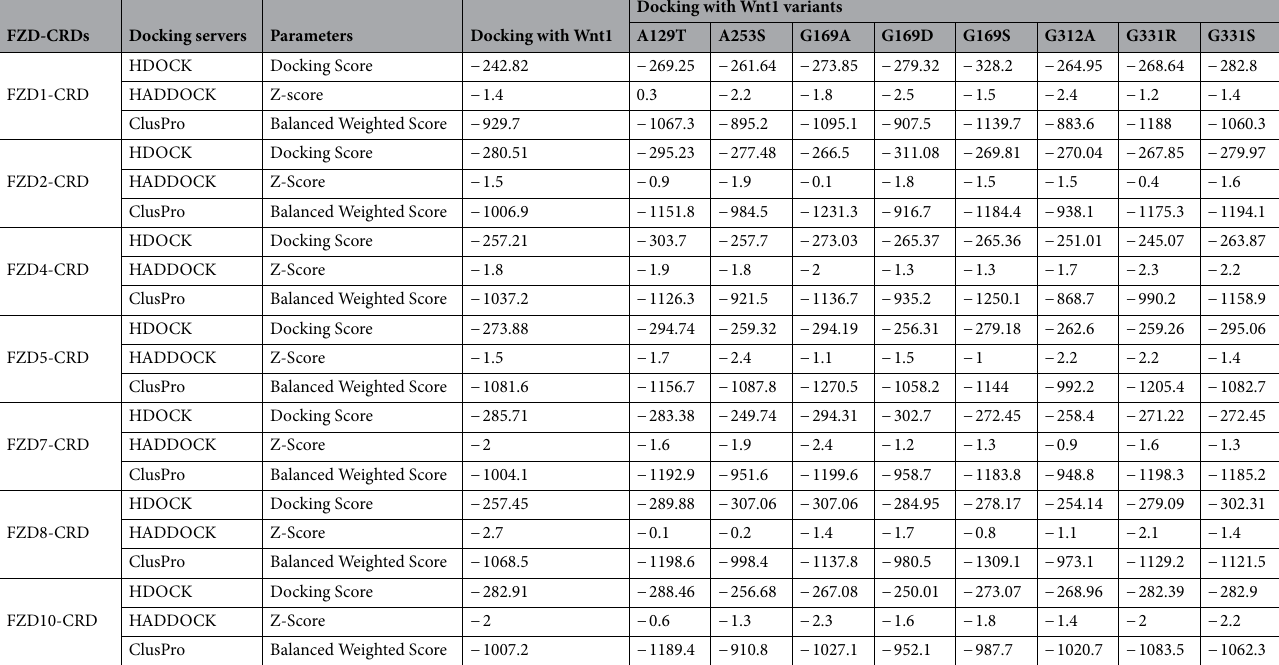
Table 4. Docking results of Wnt1 and its 8 destabilizing variants with CRD region of seven Frizzled receptors. Docking was performed by HDOCK, HADDOCK and ClusPro servers.